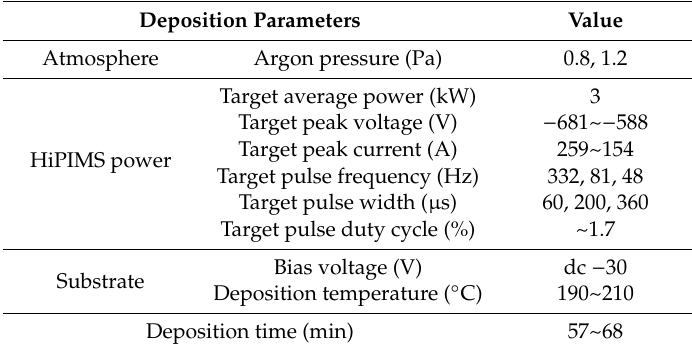
Table 1. Parameters for the trial deposition of chromium